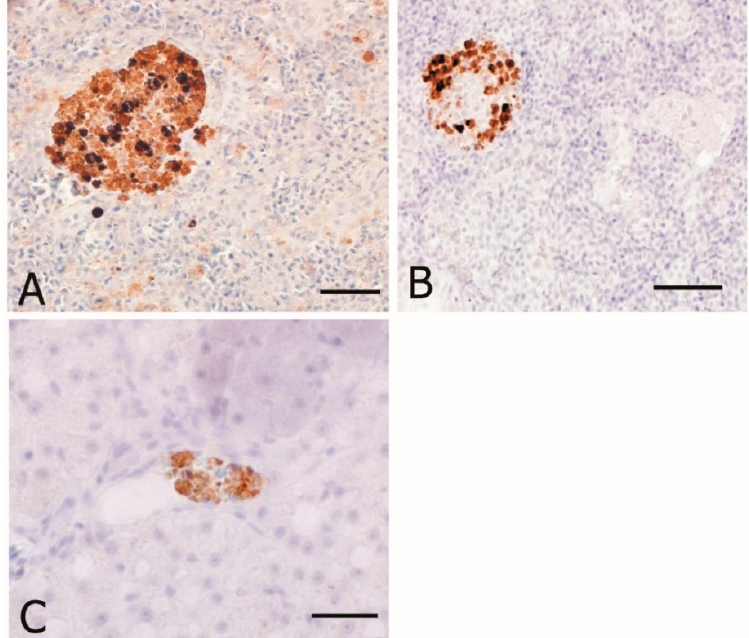
Figure 5. Immunohistochemical localization of HNE in sea bass. All panels are counterstained with Harryr’s hematoxylin. Scale bar: 50 µ m. HNE-immunostaining is present in several melanomacrophage centers located in the parenchyma of ( A ) spleen; ( B ) kidney; ( C ) liver.